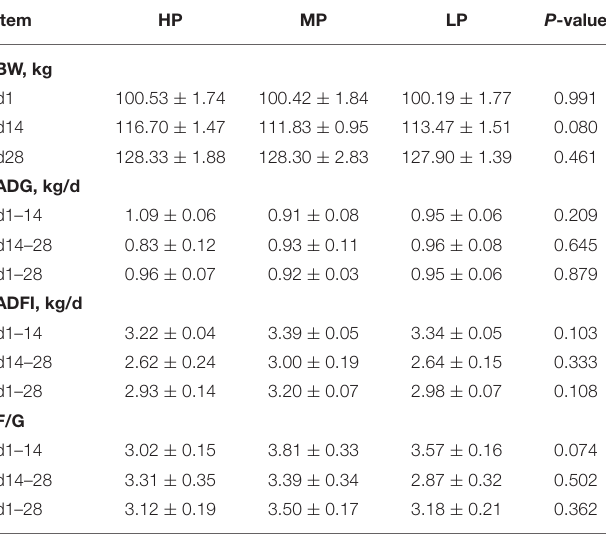
TABLE 2 | Sequences and accession number of primers for targeted genes. TABLE 3 | Effect of low protein diet on the growth performance in finishing